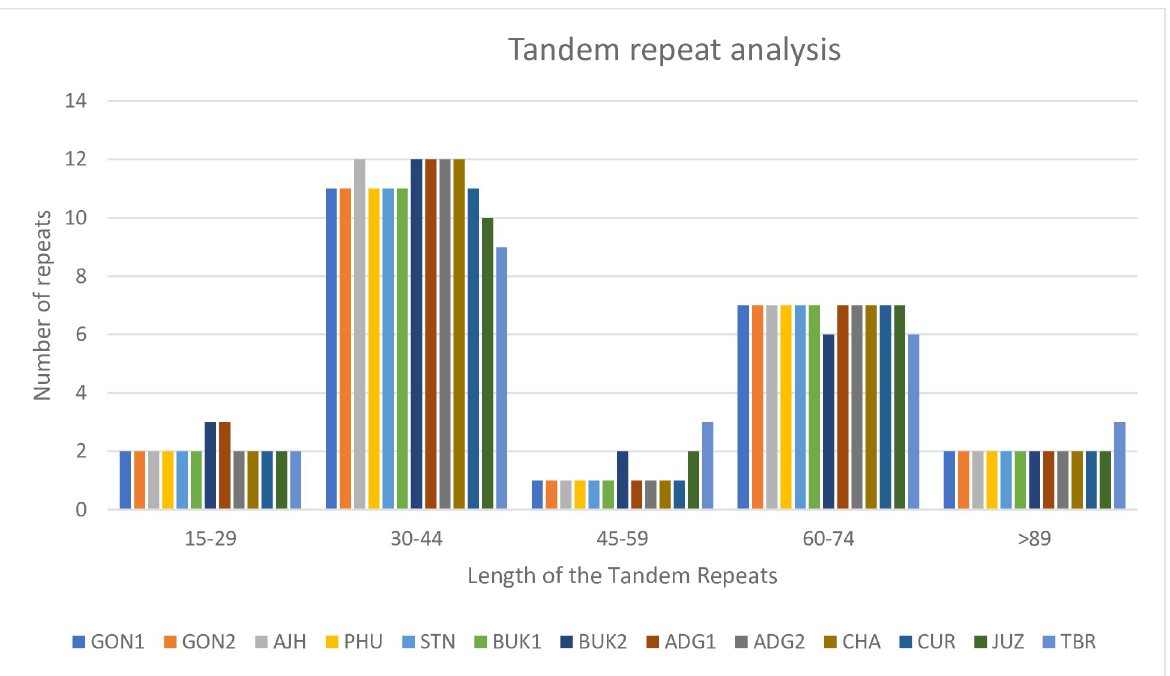
Fig 6. Analysis of tandem repeats in a panel of 13 potato plastomes. Overall, 23 to 25 tandem repeats are present in all the plastomes and their sizes range from 26 bp to 91 bp. The size of the repeats is divided into five different ranges and number of repeats present in that particular range are presented here. Most of the repeats have a size in the range of 30–44 bp.